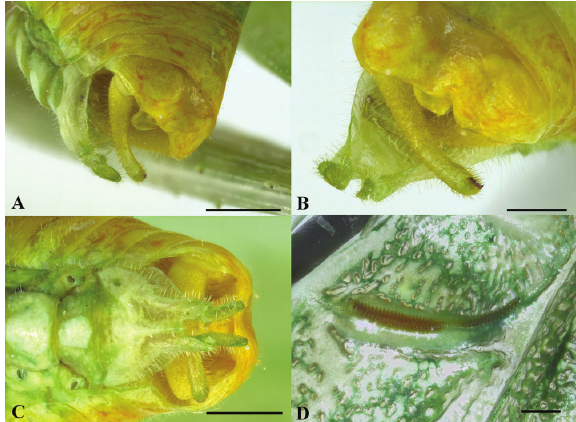
Figure 17. Morphological details of male Gonatoxia helleri sp. n. A. Semilateral view on abdominal apex. Scale bar 1 mm B. Dorsal view on abdominal apex with sclerotized ridge of cercus. Scale bar 1 mm C. Subgenital plate. Scale bar 1 mm D. Stridu- latory file. Scale bar 500